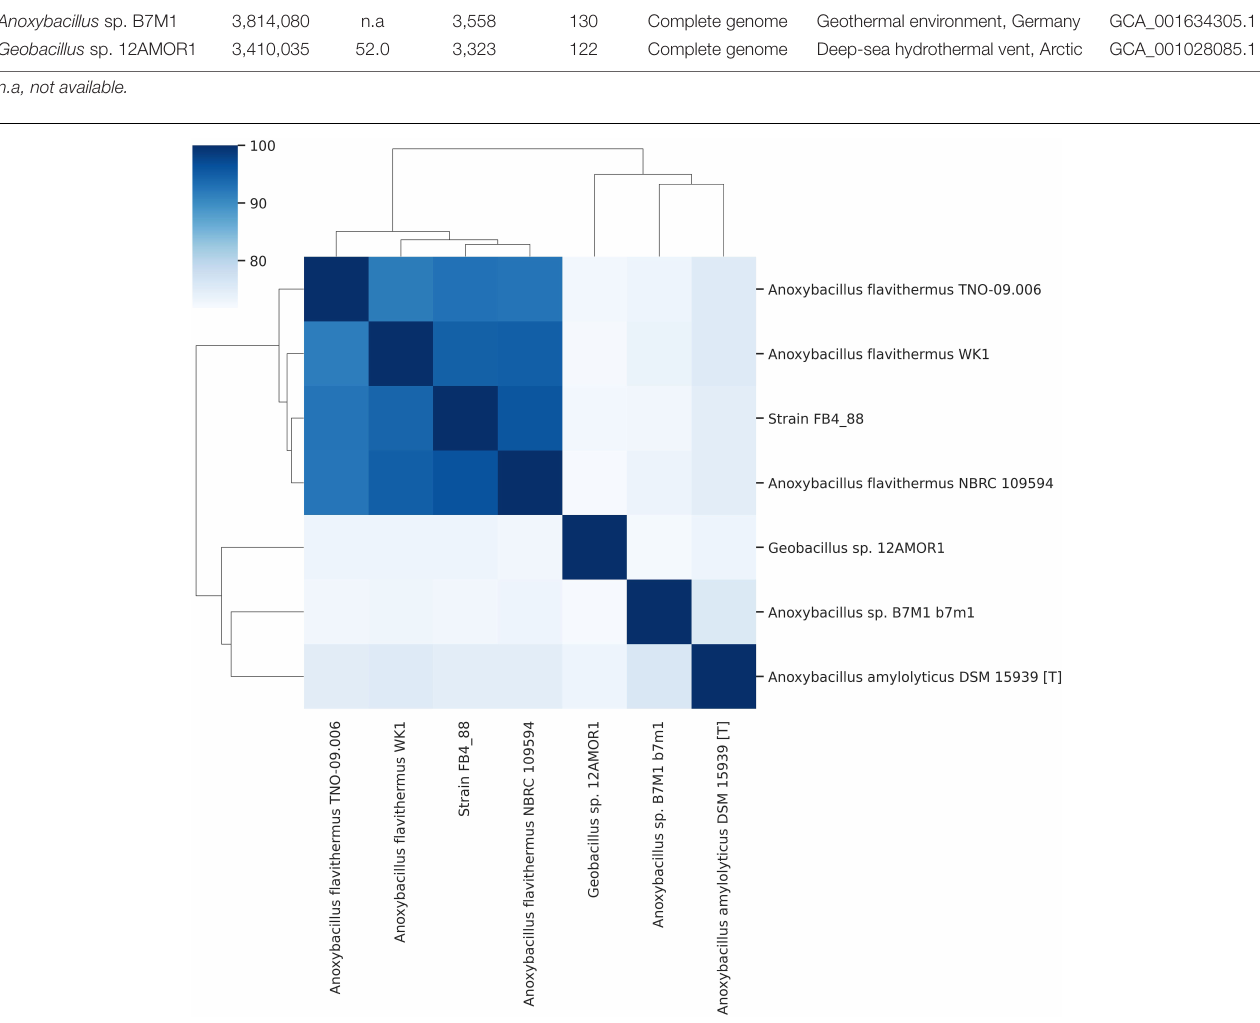
FIGURE 4 | Genomic comparison between different strains of Anoxybacillus analyzed in this study and Bacillaceae members, using ANIb (in %). On the basis of the % ANIb, the analyzed strains formed two groups, and the analyzed genome clustered with Anoxybacillus flavithermus strains.